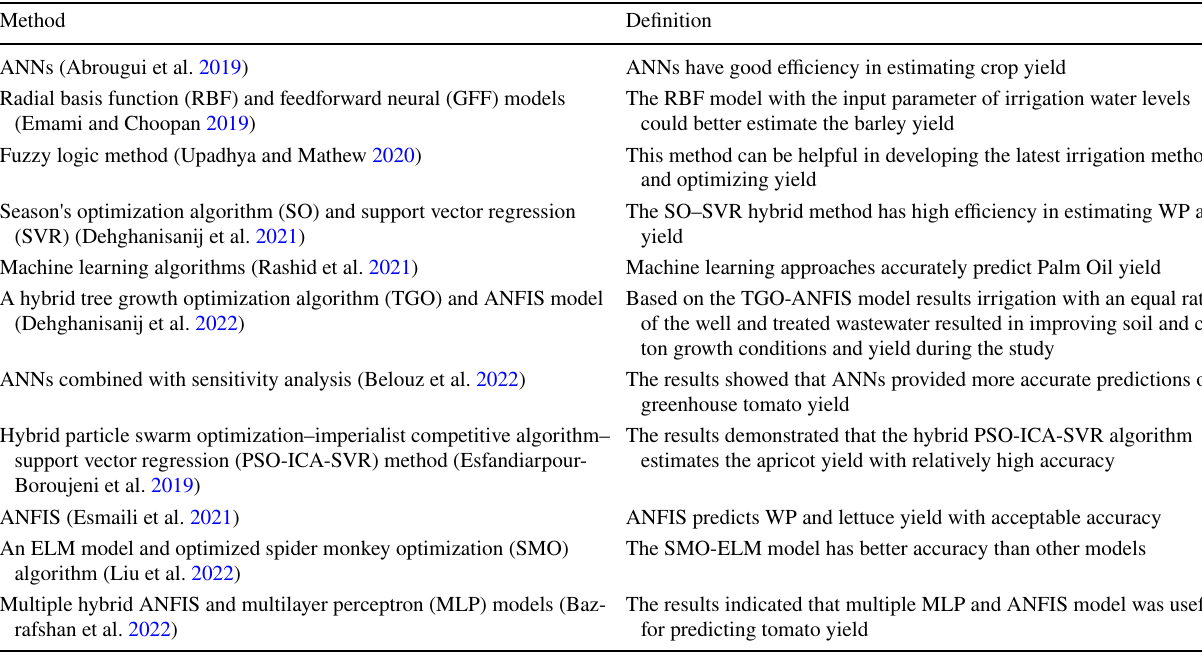
Table 1 Key points of intelligent methods in estimating crop yield and WP